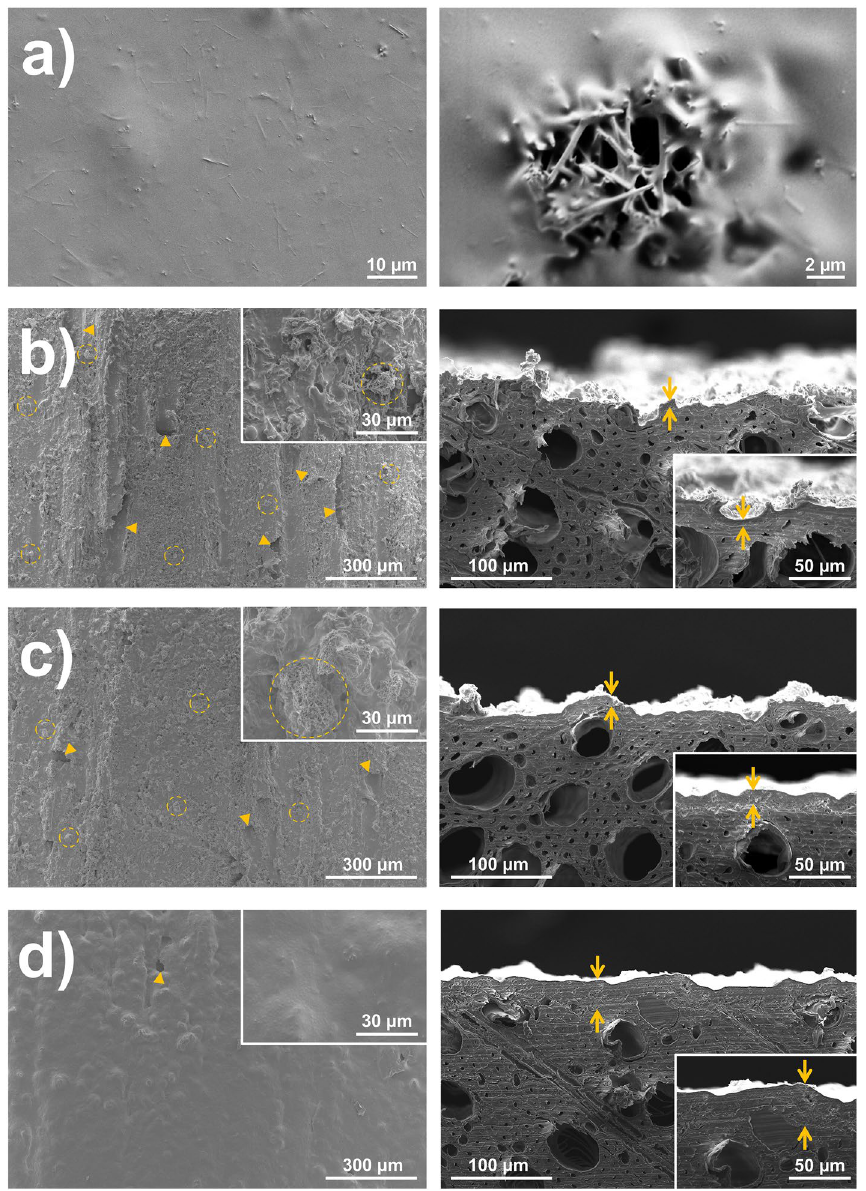
Figure 5. SEM images in ( a ) show the microstructure of the cured C + MoO 3 droplet (left) and the MoO 3 nanowires embedded in the PVDF-HFP/PVP polymer (right). Images ( b )–( d ) show the surface of wood coated with different wet film thicknesses of C + MoO 3 : ( b ) 90 µm, ( c ) 180 µm and ( d ) 360 µm. The left images show the surfaces structure: Triangular arrows are pointing the pores in the coating films, while the clusters of MoO 3 nanowires are encircled with the dashed lines. The right images show the cross-sections structure: The clear transition between cellular wooden substrate (bottom) and the film of C + MoO 3 is clearly visible only in ( c ) and ( d ). The estimated dry film thicknesses present the distance between the contradictory